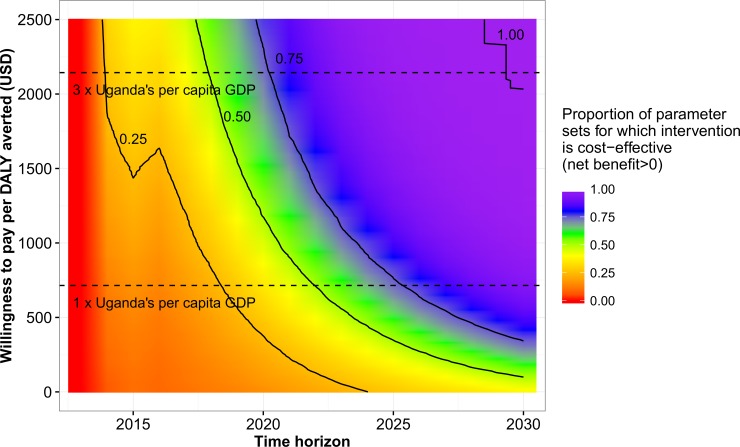
Probability that the change in CD4 threshold is cost-effective, by time horizon and willingness to pay per DALY averted.Black lines indicate where 25%, 50%, 75%, and 100% of parameter sets are cost-effective. Horizontal dashed lines indicate one and three times Uganda’s per capita GDP.